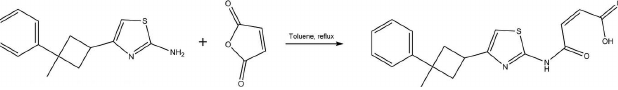
Crystal data Chemical